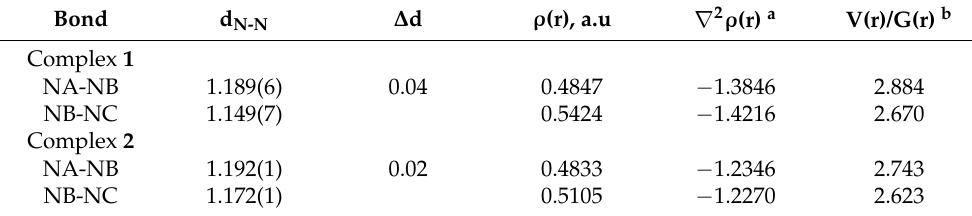
Figure 9. Hirshfeld surfaces and pie chart showing the intermolecular interactions in 2 . A–C in the d norm map belong to the O…H, N…H and C…C contacts, respectively. Table 7. The topological parameters of the azide N-N bonds.